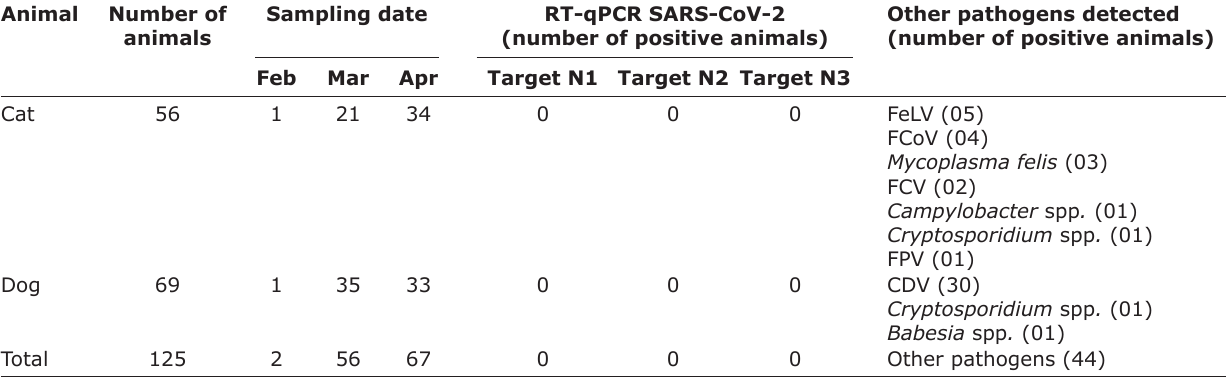
Table-1: Data from analyzed samples along with SARS-CoV-2 testing.